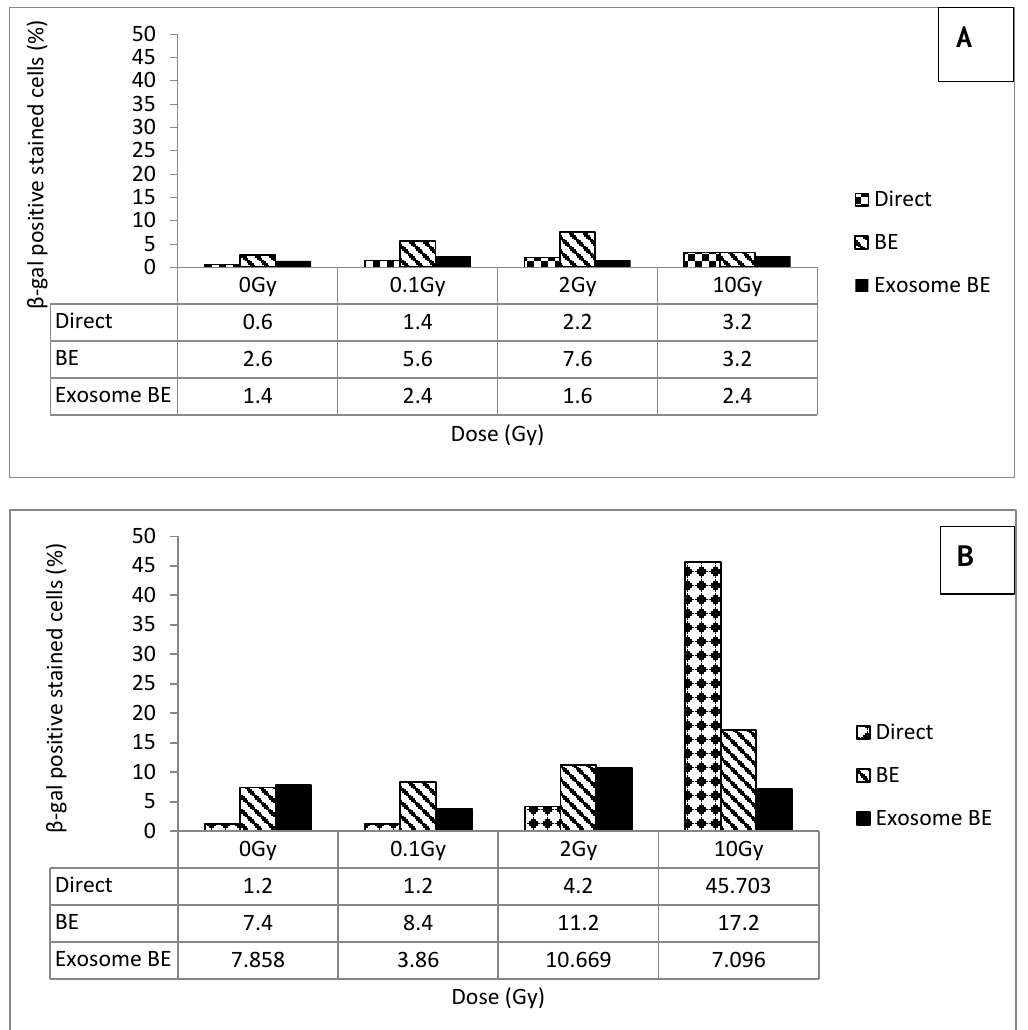
Figure 5. The induction of senescence was analyzed in cells exposed directly to radiation, or to media or exosomes from irradiated cells at 24 h (panel A ) and 15 days (panel B ) following irradiation. Panel ( A ) shows an increase in the percentage of cells experiencing senescence following exposure to irradiated media from 0.1 Gy (a significant increase, p = 0.0252, at p < 0.05) and 2 Gy (a significant increase, p = 0.0008, at p < 0.05) (media bystander effect) compared to their corresponding control. However, a small increase in cells experiencing senescence was observed at 2 Gy (insignificant increase, p = 0.0558, at p < 0.05) and 10 Gy (a significant increase, p = 0.0041, at p < 0.05) direct irradiation. Panel ( B ), shows a significant increase in the level of senescent cells in the direct irradiated 10 Gy group and media bystander 10 Gy group compared to their corresponding controls. Interestingly, cells cultured with exosomes from irradiated cells at 10 Gy showed a reduction in the level of senescence. As seen in our earlier results, 10 Gy direct irradiation induces substantial senescence (~46%)